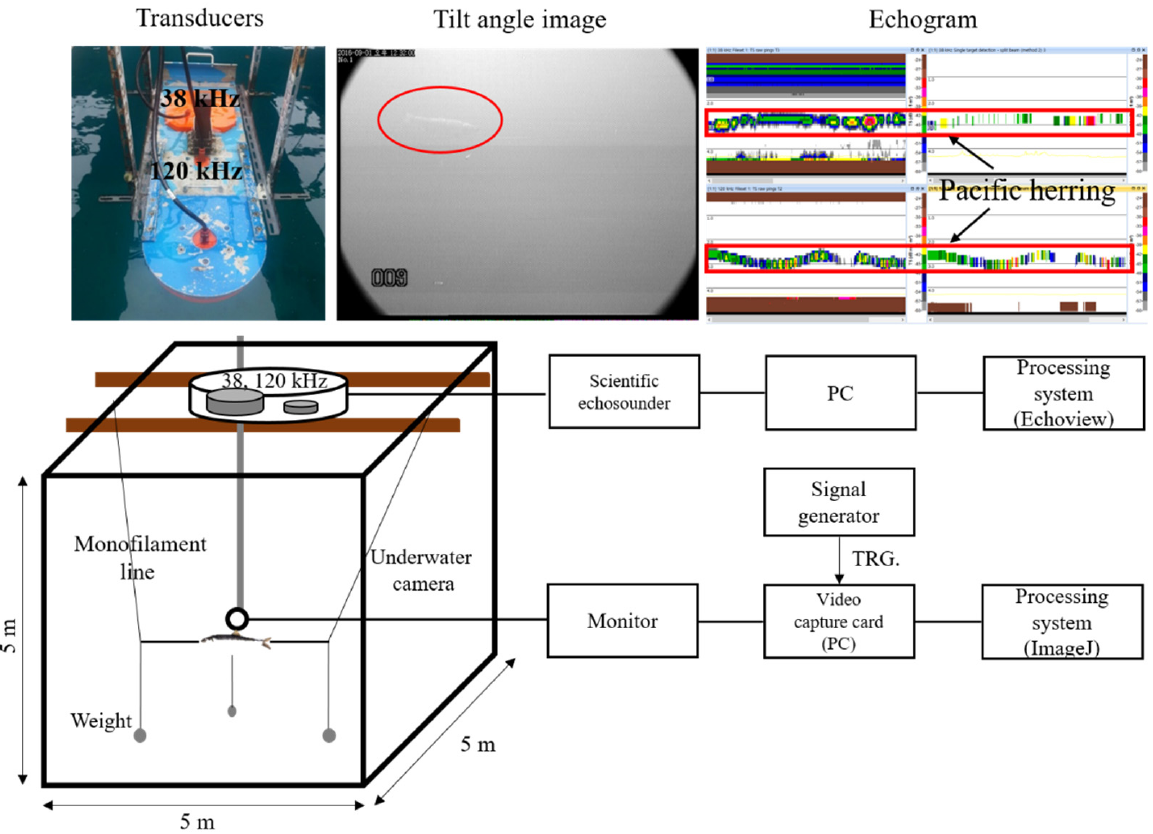
Figure 2. Block diagram of the experimental system, and a picture of the equipment used to measure Pacific herring TS.